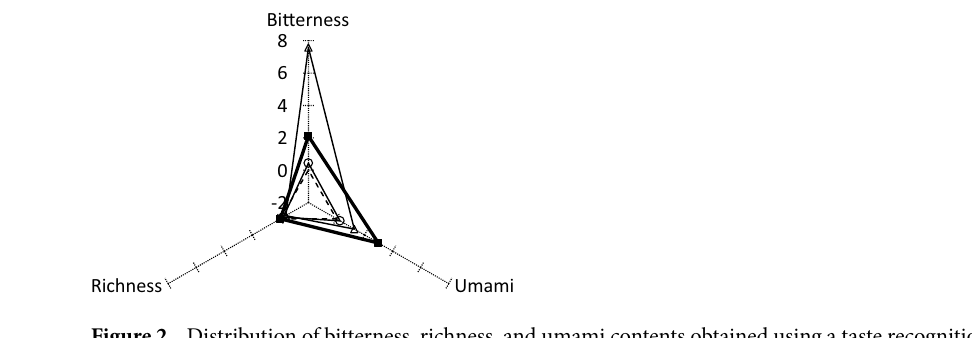
Figure 2. Distribution of bitterness, richness, and umami contents obtained using a taste recognition device. Values are shown relative to the control (dotted line). White circles indicate anserine only; white triangles indicate carnosine only; black squares indicate anserine and